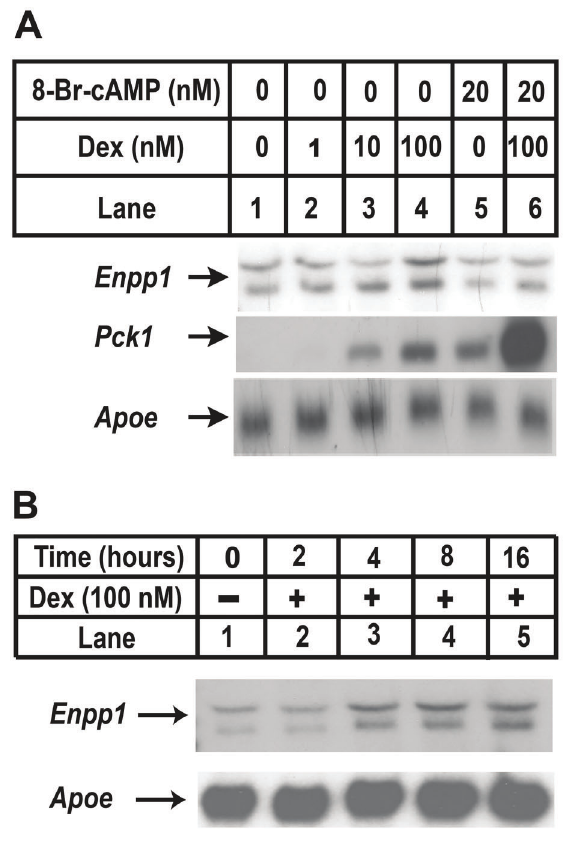
Figure 3. Total RNA was isolated and subjected to northern blot analysis. A , mRNA levels of Enpp1 , Pck1 , and Apoe in hepato- cytes treated with 0, 10, 100 nM dexamethasone (Dex) or 20 nM 8-Br-cAMP in the absence or presence of 100 nM Dex for 16 h. B , mRNA abundance levels of Enpp1 and Apoe in hepatocytes treated with 100 nM dexamethasone for 0, 2, 4, 8, or 16 h. Enpp1 : Ectonucleotide pyrophosphatase/phosphodiesterase 1 gene; Apoe : apolipoprotein E gene; Pck1 : cytosolic form of phosphoenolpyruvate carboxykinase